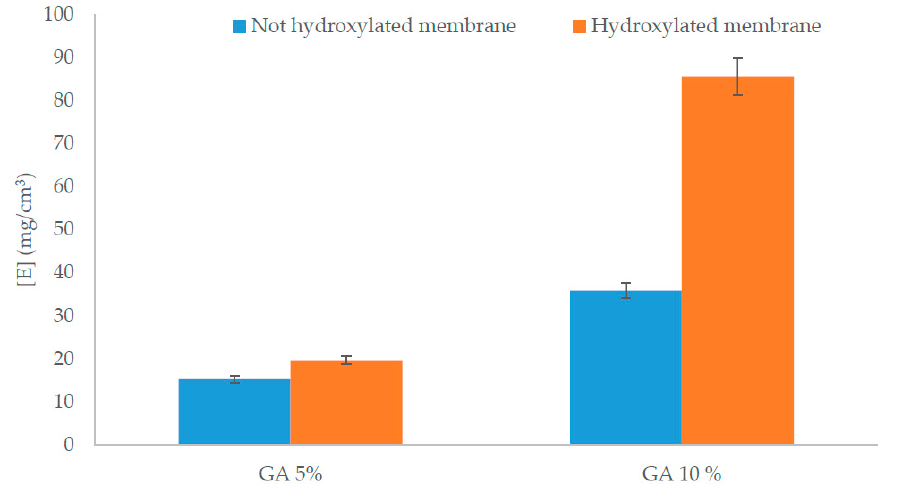
Figure 2. Immobilized enzyme amount depending on hydroxylation and GA concentration.